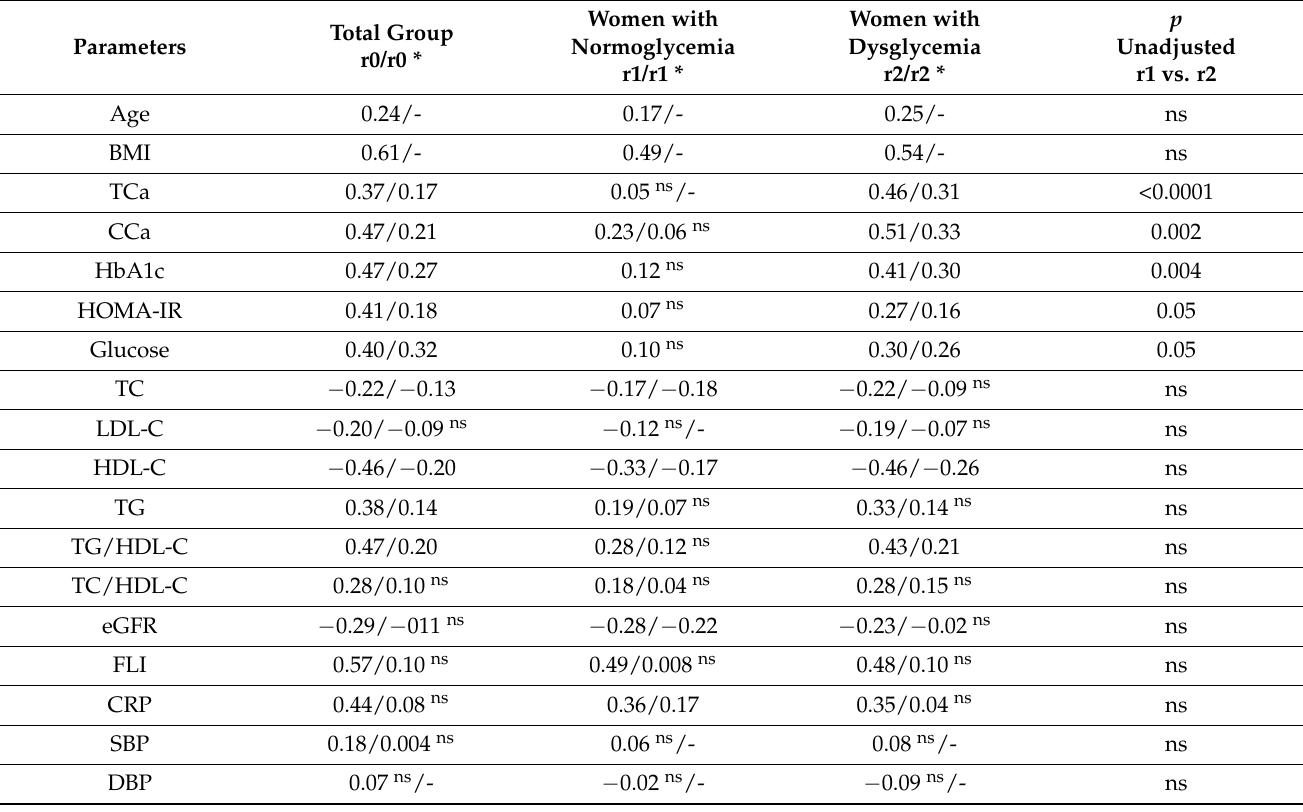
Table 2. Unadjusted and adjusted correlation coefficients between BCAAs and cardiometabolic risk factors.